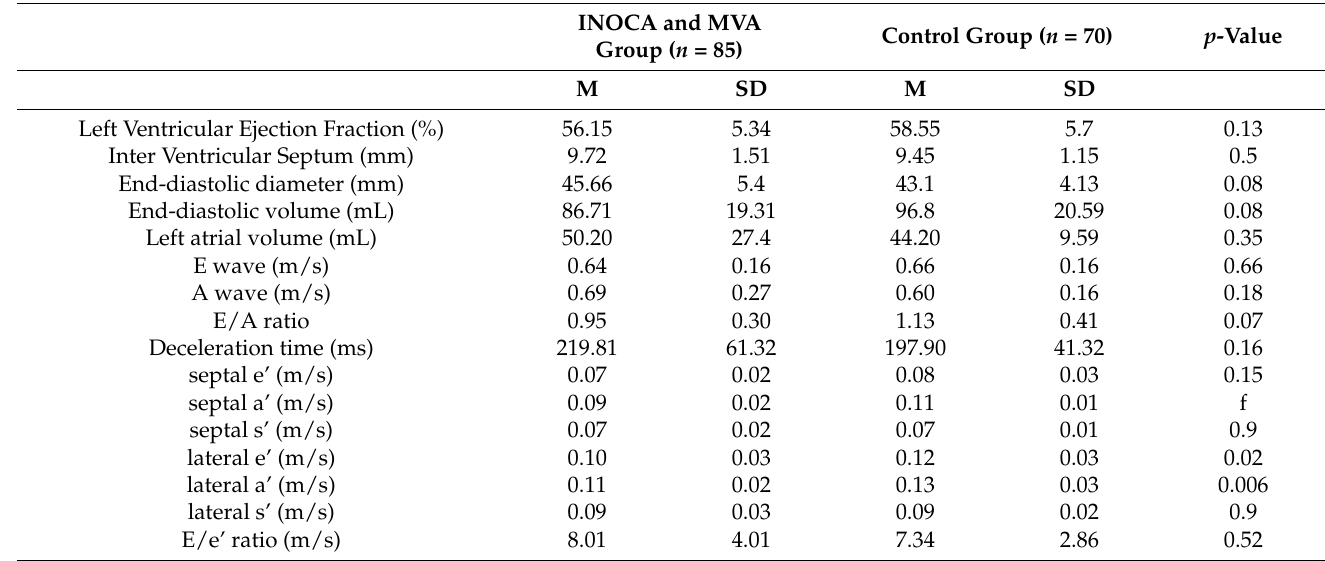
Table 1. Comparison of baseline echocardiographic data in the INOCA and MVA and control group.